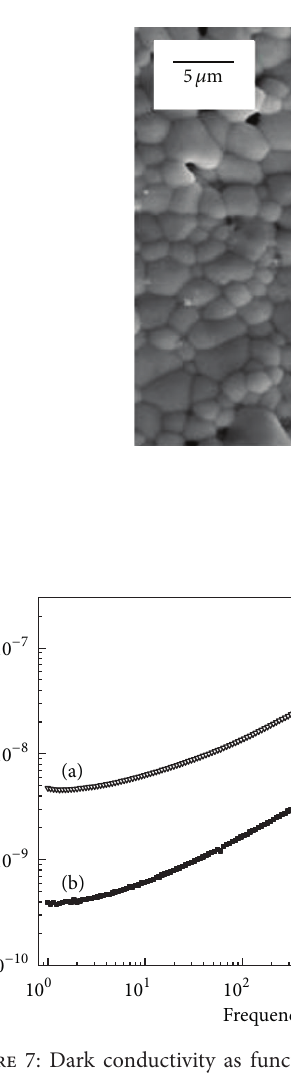
Figure 7: Dark conductivity as function of the frequency of the ceramics sintered at 750 ∘ C/1h, using the powders calcined at (a) 450 ∘ C/1h and (b) 600 ∘ C/1h.